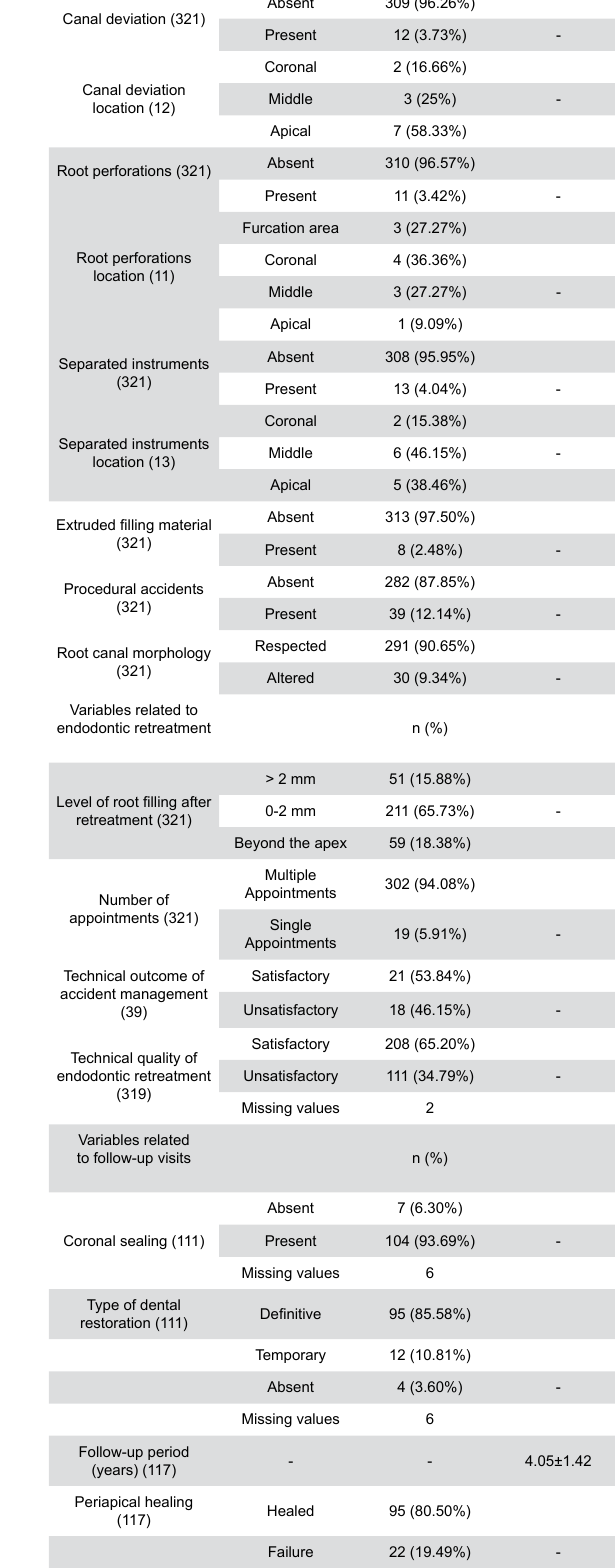
Table 1- Distribution of variables related to medical history, diagnosis, endodontic retreatment, and follow-up visits (N = 321)